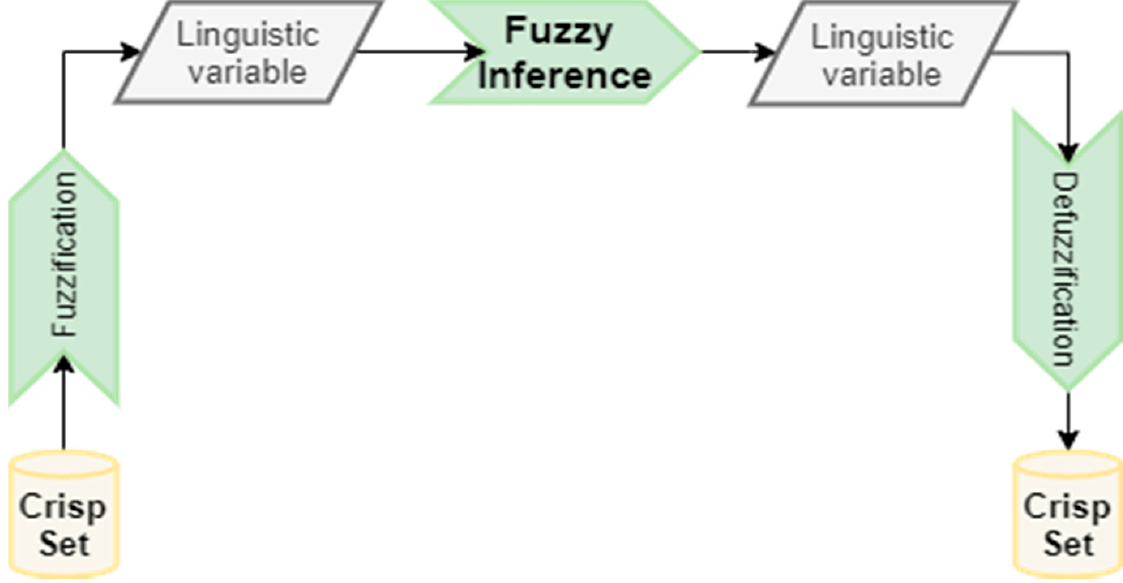
Figure 7. The structure of the Fuzzy Inference System.